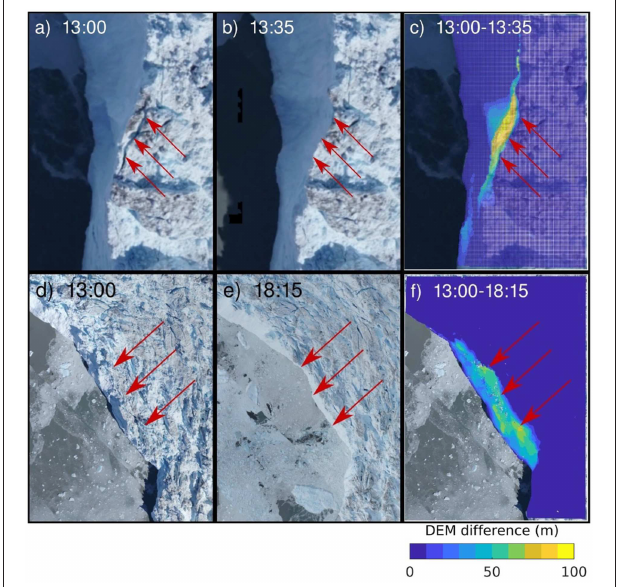
FIGURE 11 | For each row, the first and second panel shows ortho-images before and after a calving event occurred at Eqip Sermia on 7 July 2018, while the third panel shows the difference of the two corresponding DEMs. (a–c) refer to a small-scale event that occurred between 13:00 and 13:35, while (d–f) refer to a larger event that occurred between 13:00 and